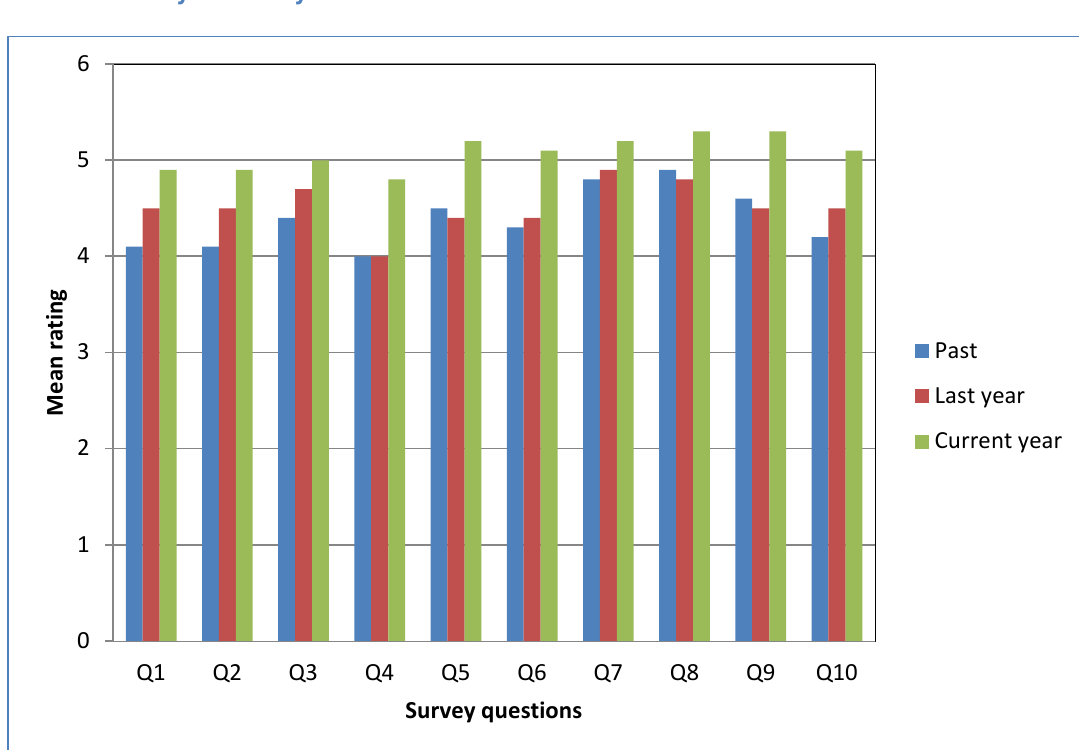
Table 1 Summary of survey